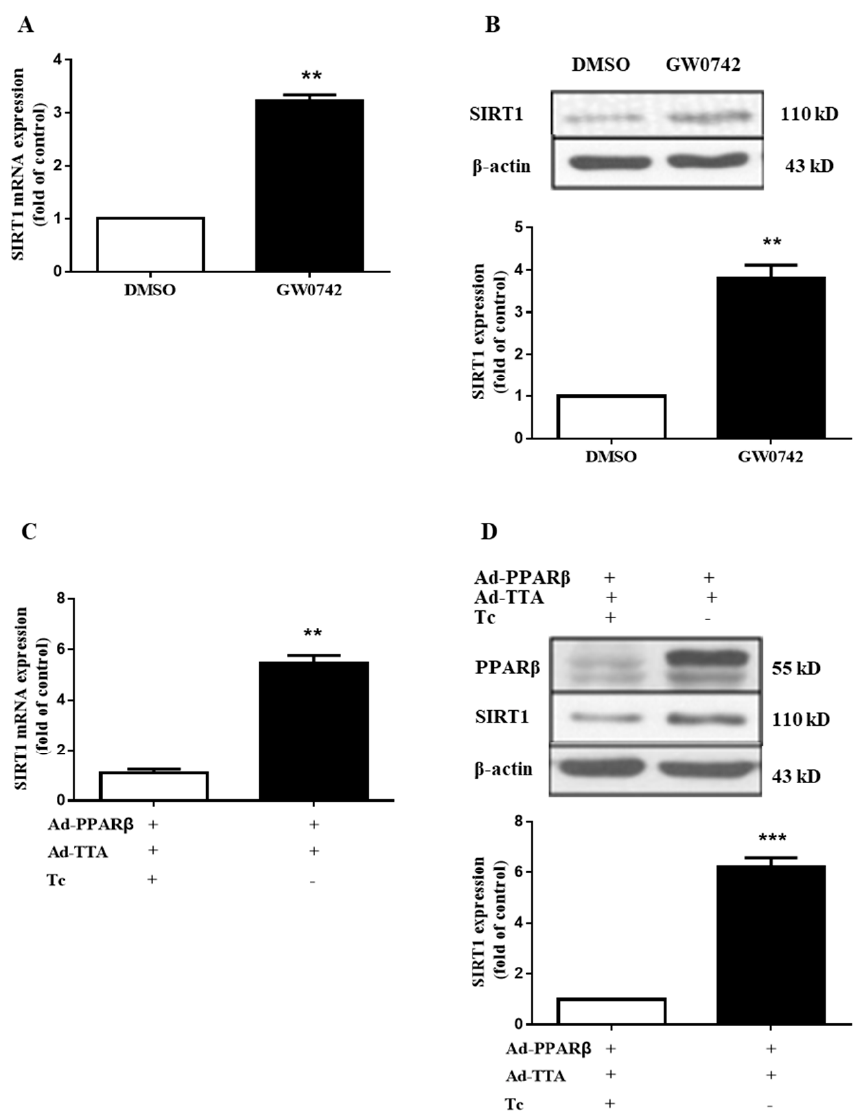
Figure 5. PPAR β / δ increases expression of SIRT1 in glomerular mesangial cells. ( A , B ) PPAR β / δ activation by GW0742 increased SIRT1 mRNA ( A ) and protein ( B ) expressions. The cells were treated with or without GW0742 (1 µ M) for 6 h. SIRT1, COX-1, and COX-2 expression levels were analyzed with real-time PCR and Western blot. ** p < 0.01 vs. DMSO; n = 3. ( C , D ) Adenovirus-mediated PPAR β / δ overexpression upregulated SIRT1 mRNA ( C ) and protein ( D ) expressions. The cells were infected with Ad-PPAR β / δ and Ad-TTA (25 MOI) with or without 0.1 µ g/mL tetracycline